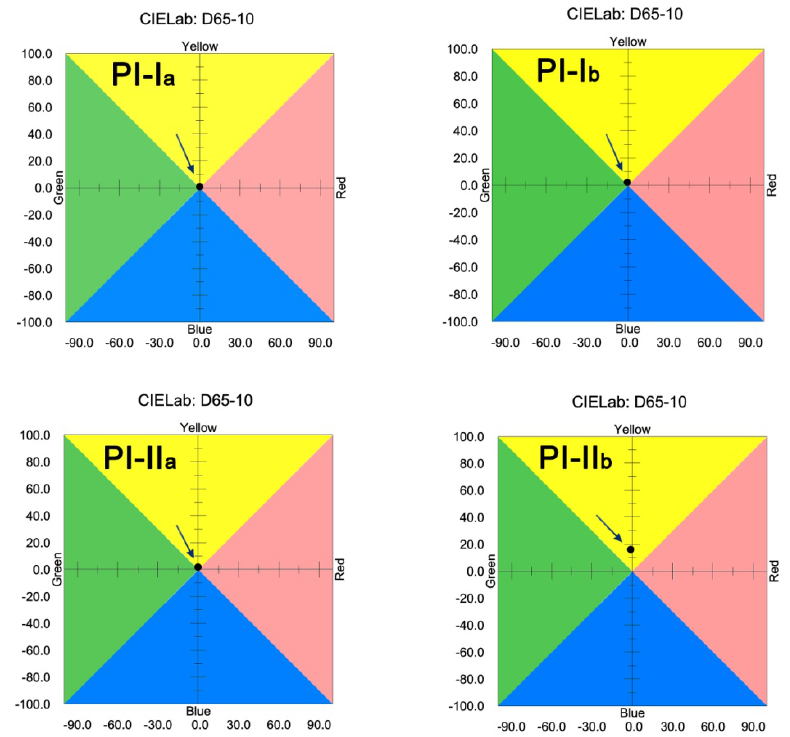
Figure 9. CIE Lab color parameters of PI films.